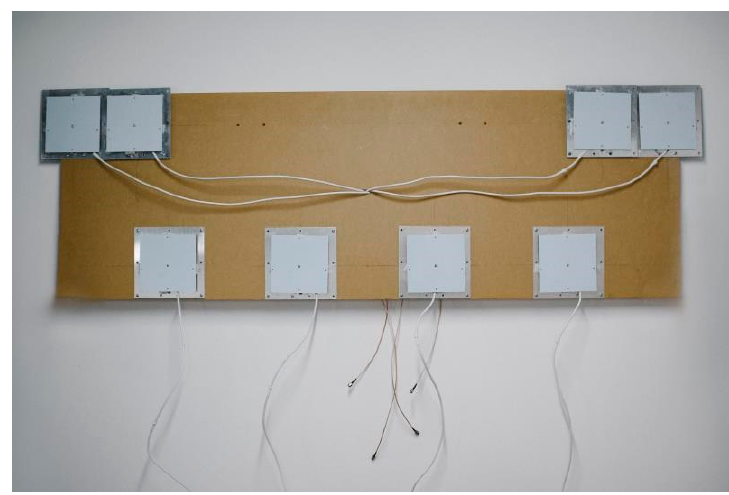
Figure 5. MIMO radar antennas.